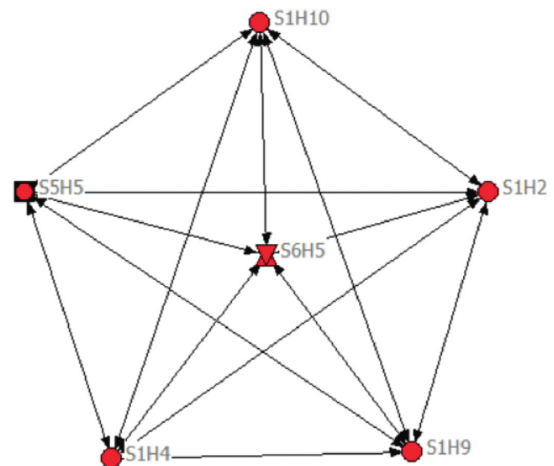
Figure 5: The network between these 6 safety risk factors in G1 (based on frequency co-presentation